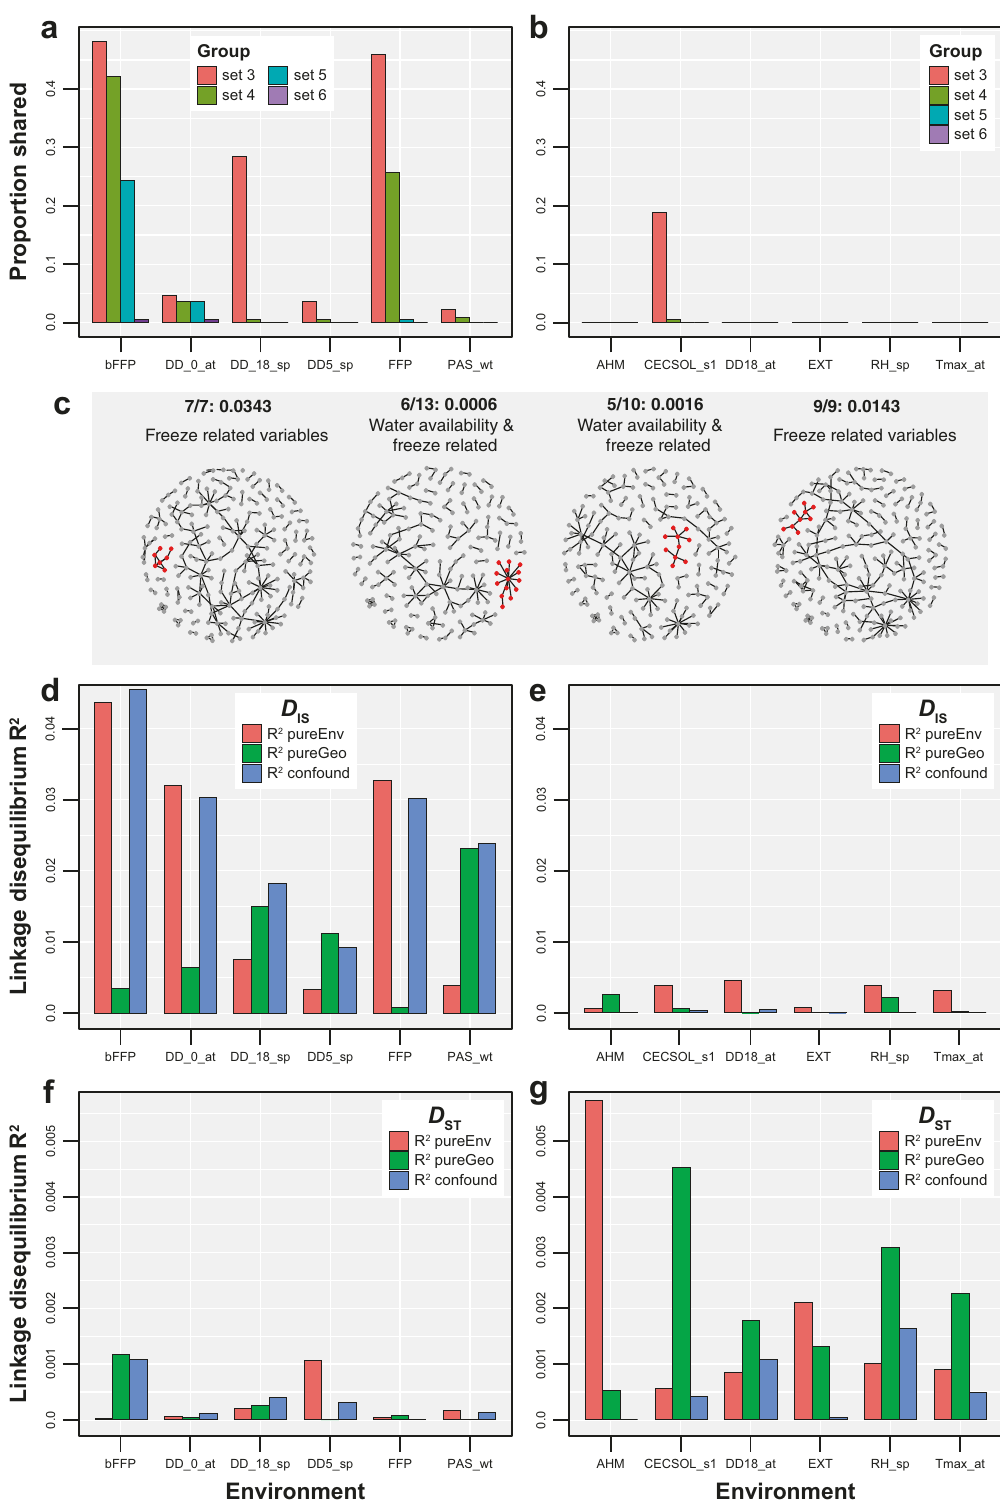
Fig. 3 Representation of linkage disequilibrium (LD)-based detection of outlier SNP clusters and LD variance partitioning for environmentally associated SNPs identi fi ed from Bayenv. Proportion of times groups of Bayenv outlier SNPs were shared in a given outlier cluster (OC) across 100 replicates of LDna for a strongly divergent and b least divergent environmental gradients between P. strobiformis and P. fl exilis. c Representation of one of the replicated sets from LDna, with red points indicating SNPs in the OC. The proportion of environmentally associated SNPs per OC, median LD for the cluster and the major environmental gradient of association for each OC are indicated above each network. Regression coef fi cients for within population component of LD ( D IS ) for environmental gradients that were d most divergent and e least divergent between the parental species. Regression coef fi cients for among population component of LD and ( D ST ) for environmental gradients that were f most divergent and g least divergent between the parental